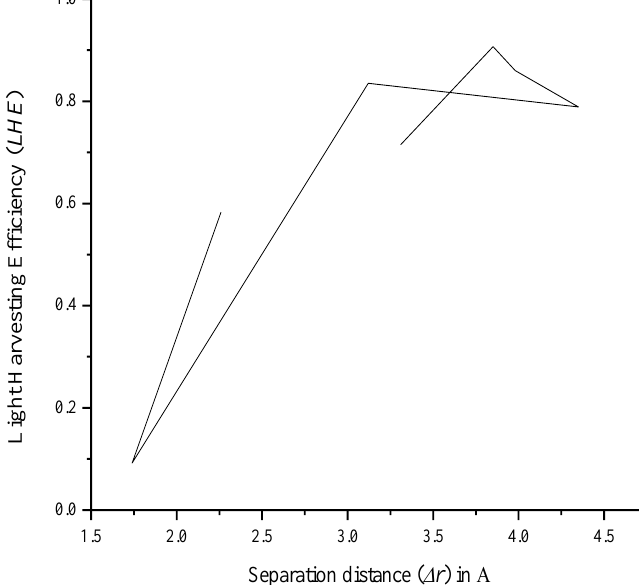
Figure 13. Graphical relationship between electron − hole separation distance and light-harvesting efficiency.